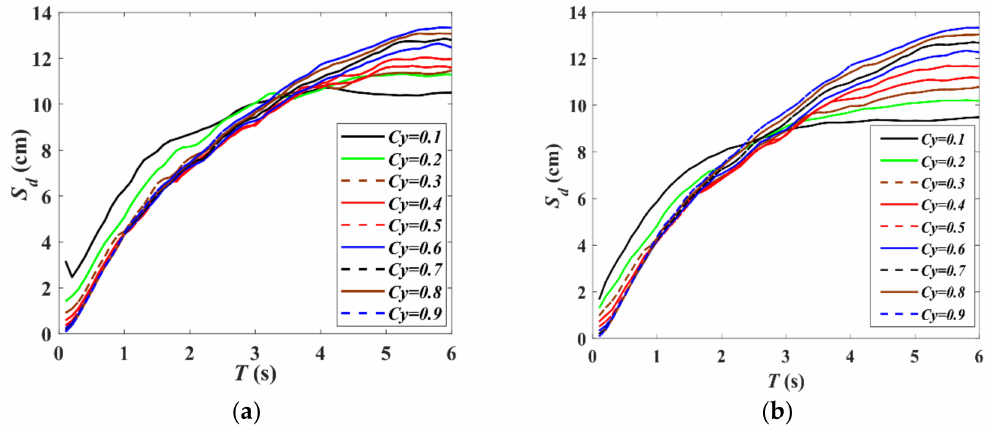
Figure 3. The S d mean spectrum under different C y conditions. ( a ) Bilinear model, ( b ) modified Clough model.